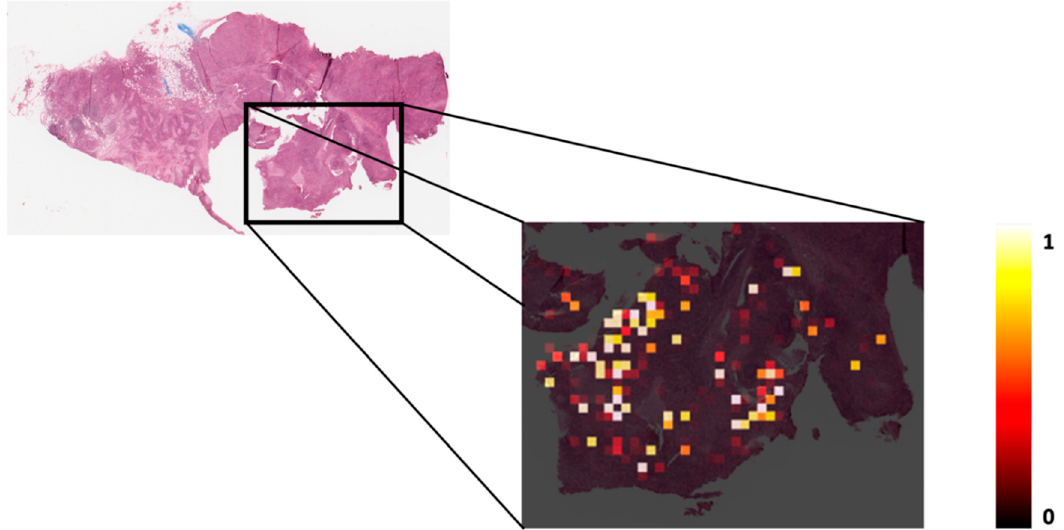
Figure 2. A whole slide image (32x) and corresponding heatmap for a single patient in the independent test set. The intensity of coloring in the heatmap represents the probability of being class-positive in the CNN (convolutional neural network) step.